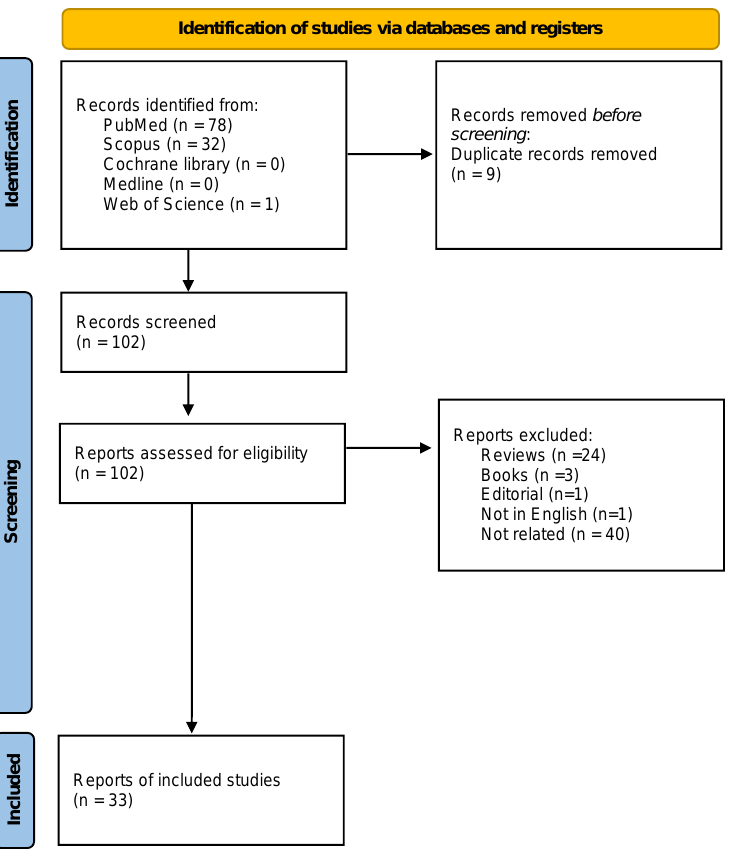
Figure 2. PRISMA 2020 flow diagram for new systematic reviews which included searches of databases, registers, and other sources.